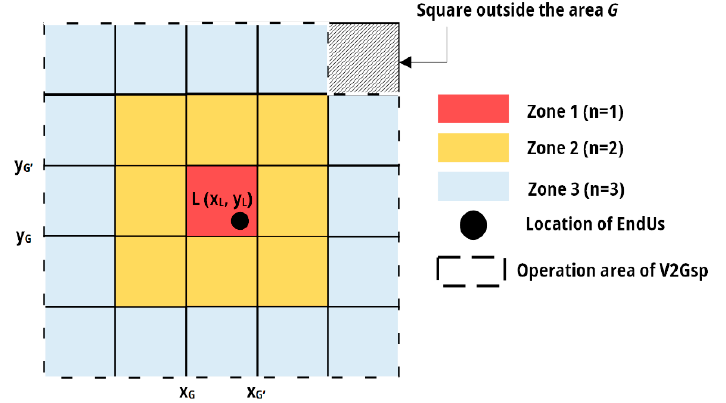
Figure 4. Exemplary determination of EV search zones.